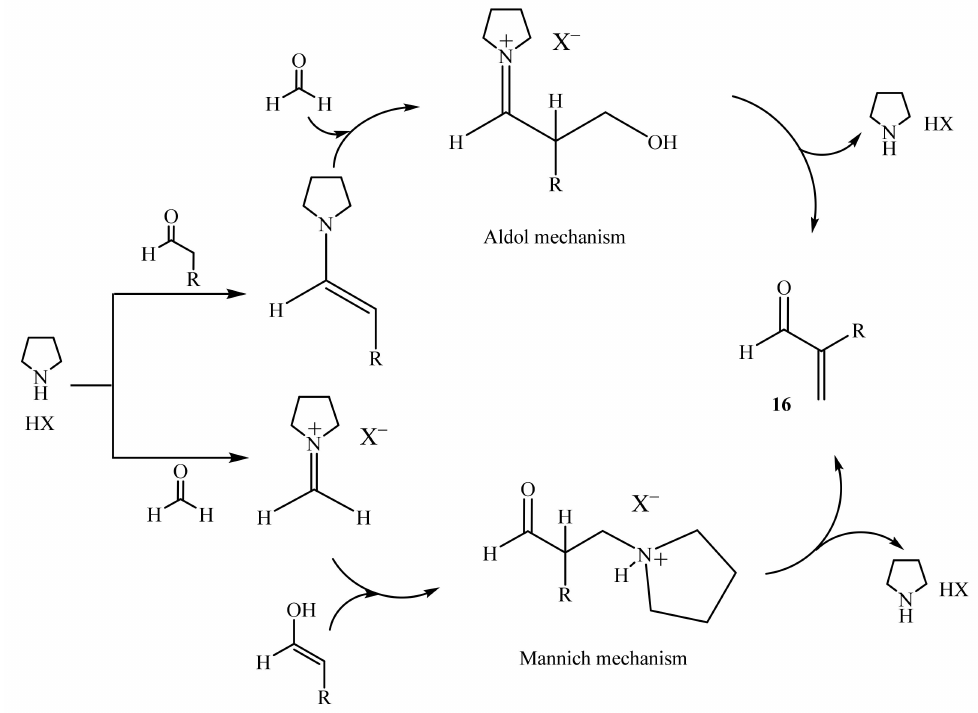
Scheme 5. Possible mechanisms for the α -methylenation